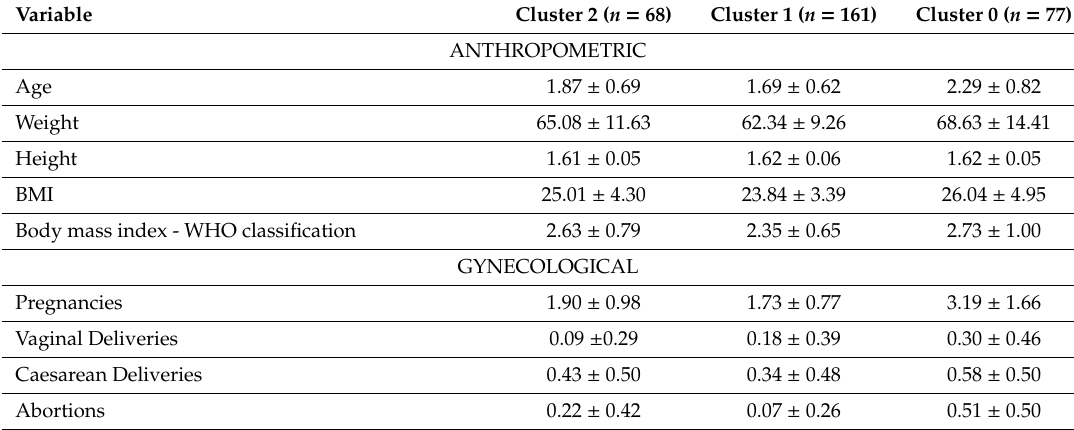
Table 5. Characteristics stratified by all features. Features are presented as mean ±